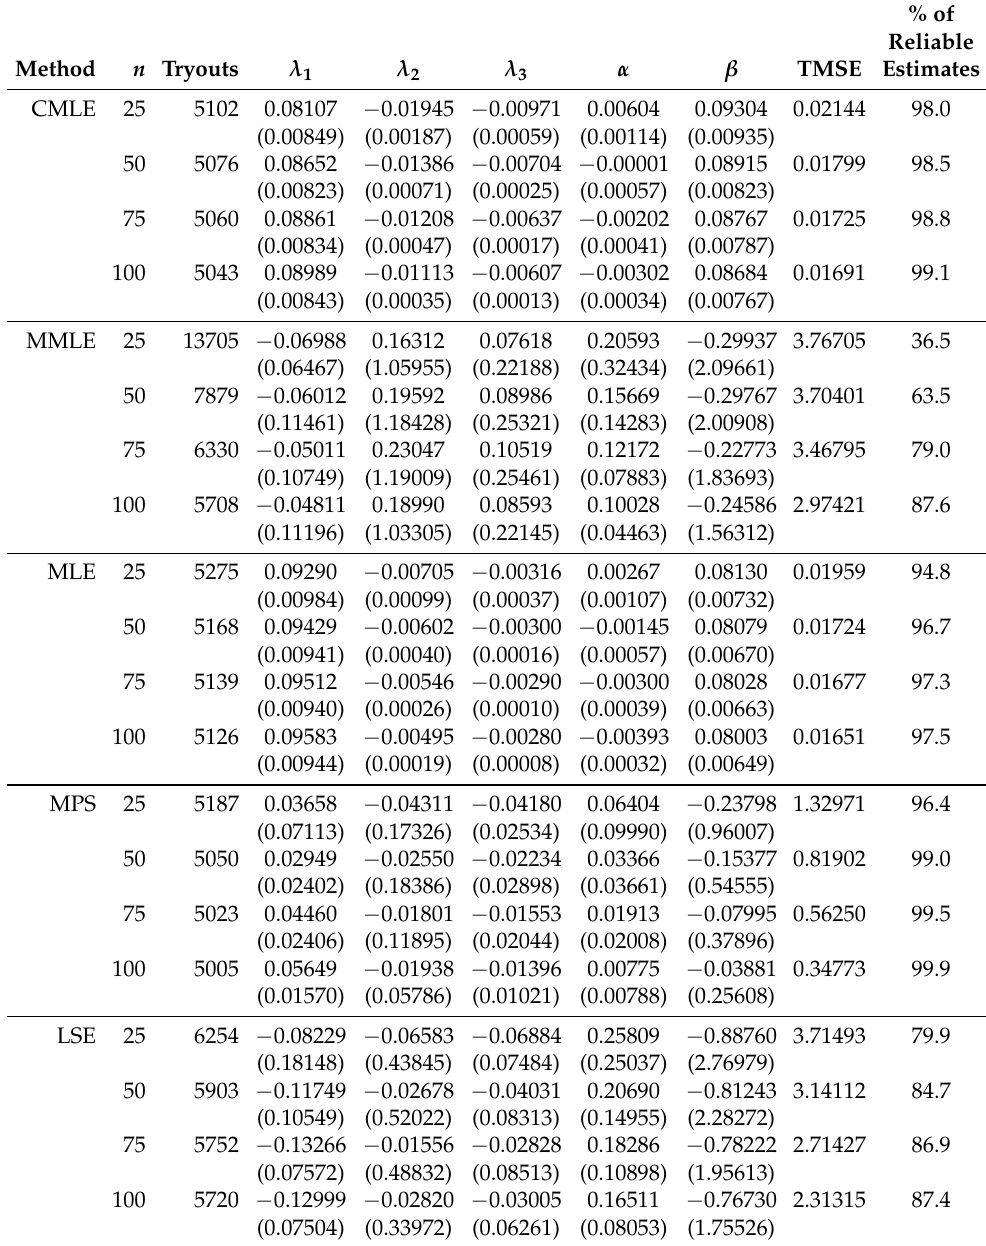
Table 6. Simulated biases and MSEs (in parentheses) of the parameter estimates obtained based